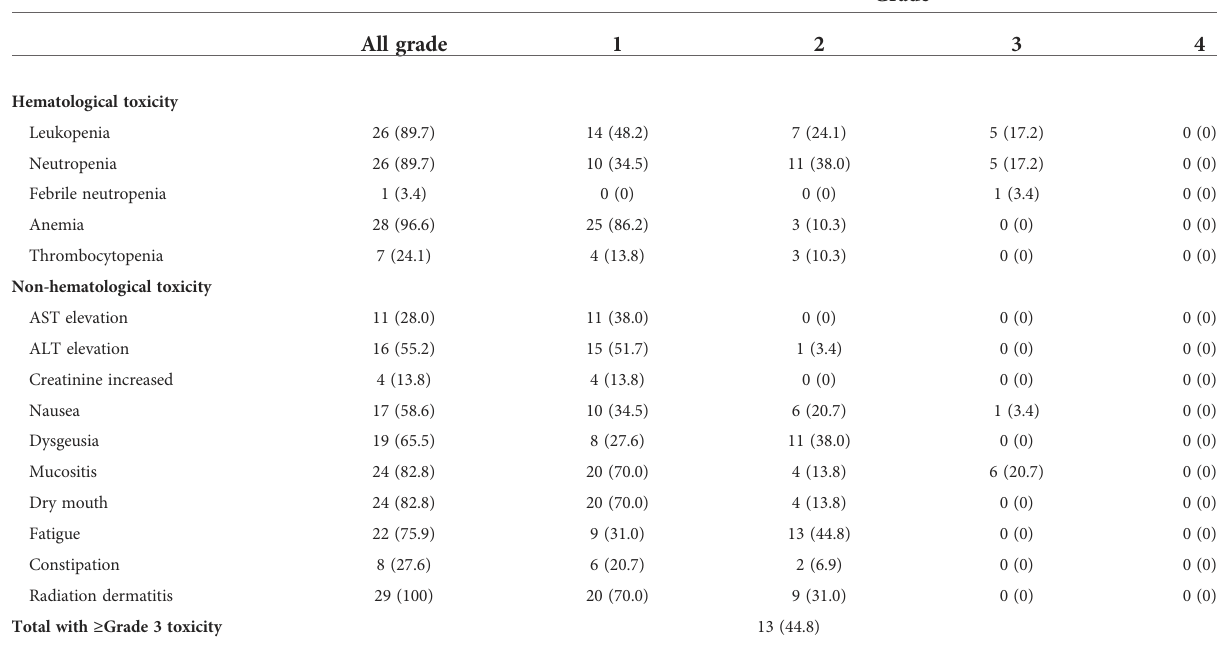
TABLE 4 Selected toxicity during